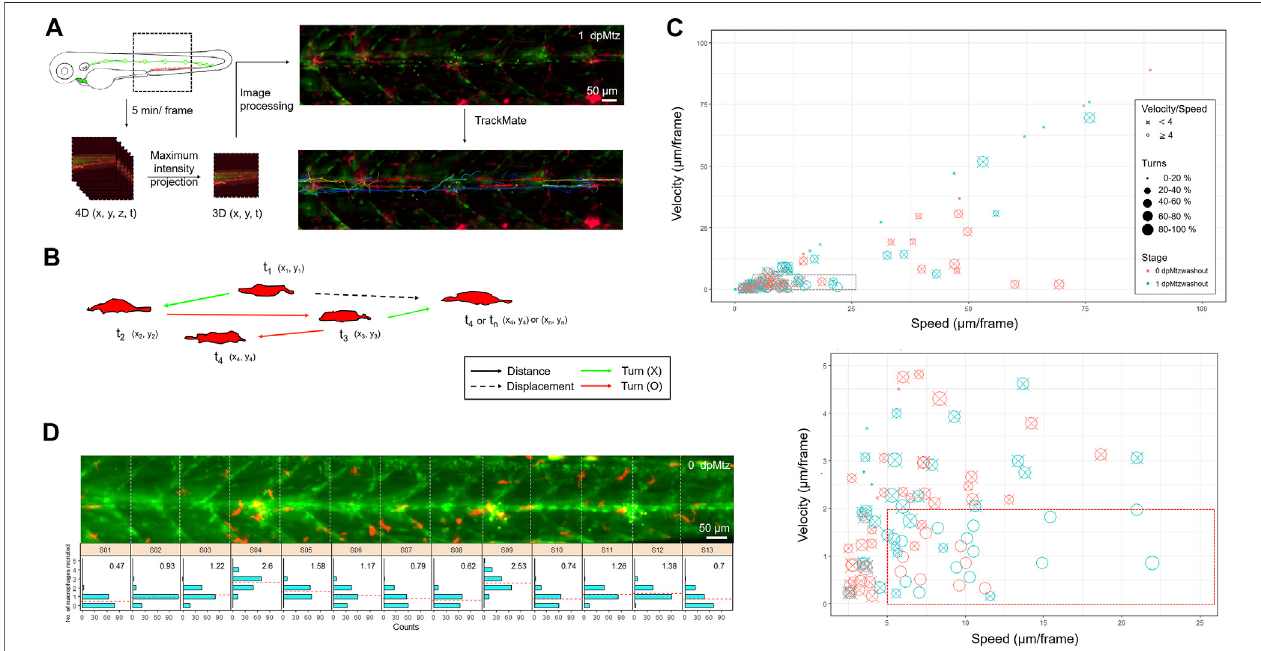
FIGURE 7 | In toto imaging analysis reveals differential cell behaviors and speci fi c spatial distribution of macrophages during neuromast regeneration. (A) The fl owchart shows that the trunk region, including neuromast L3-5 was imaged in-toto by light-sheet fl uorescence microscopy (LSFM) to monitor macrophage behavior during neuromast regeneration. Larvae from the cross of Tg(mpeg1:mCherry;FoxD3:GFP) and Tg( − 8.0cldnb:NTR-hKikGR); Et(HG7L) , a wide fi eld of z-stack images focusing around the cloaca (dashed rectangle) was taken every 5 min. We then reduced the order to 3D (x,y,t) with the stacking of z-sections and processed it to haveabetterresolutionbysubtractingthebackground.Finally,weusedtheplugin “ TrackMate ” intheFijisoftwareandmanuallymodi fi edittoacquirethetrackingpathof every macrophage (shown in the right-bottom corner). (B) We measured the distance (arrows) and displacement (arrows with dashed lines) to calculate speed and Velocity, as shown in (C) . Turns were counted among cell movements (indicated by red) to generate the ratio ofturns in (C) . (C) Ascatter plot shows speci fi c speed (the X-axis) and Velocity (the Y-axis) for each macrophage. Other features such as “ Speed/Velocity ” , “ Ratio of turns ” and “ Stage ” are also depicted as shown in the legends ontherighttodistinguishdifferentcellbehaviorsbetter.Aregionwithaspeedlowerthan25andavelocitysmallerthan10(dashedrectangle)wasmagni fi ed,asshownin thelowerpanel. (D) Histogramsdividedbysections(widthof100 μ m)representcounts(theX-axis)ofthedifferentnumbersofrecruitedmacrophages(theY-axis)during neuromast regeneration. In each panel, the mean of the “ number of recruited macrophages ” is shown in the right-upper graph and presented with dashed lines in red.